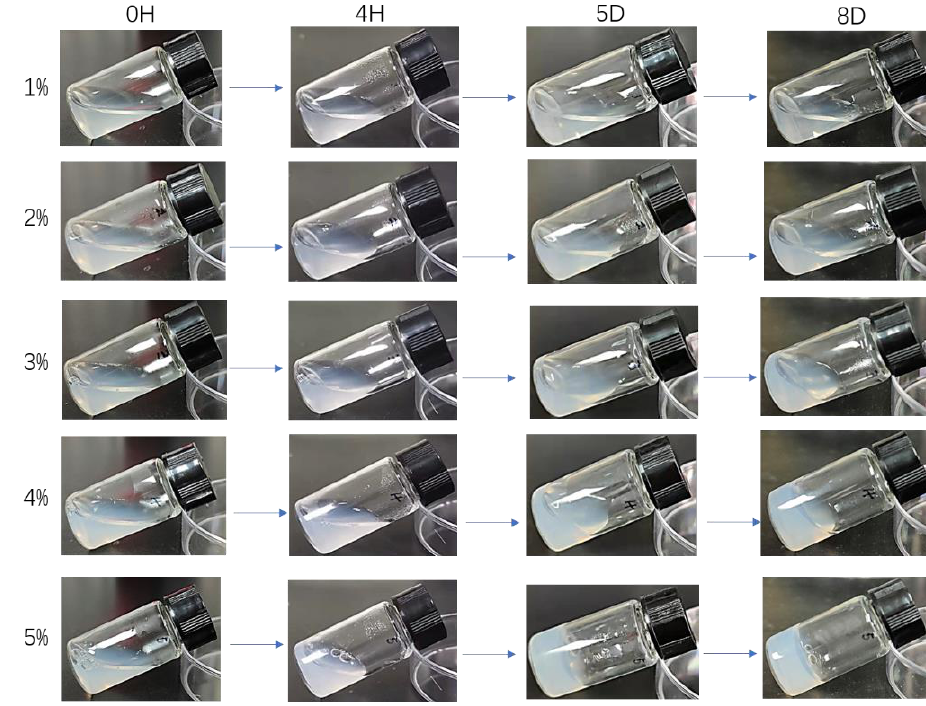
Figure 4. Optical morphology of the CSF solution stored at different time.